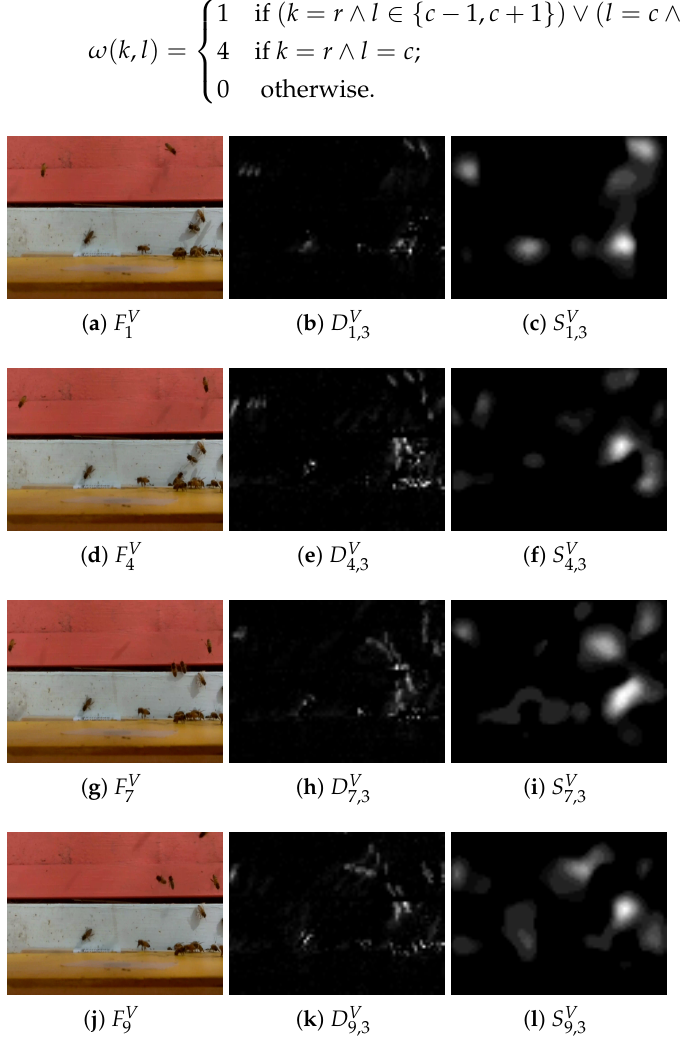
Figure 5. Smoothed difference frames S V sponding to F V function ω ( k , l ) is defined in Equation (10); blobs in smoothed difference frames correspond non-static frame regions where bee motions have been